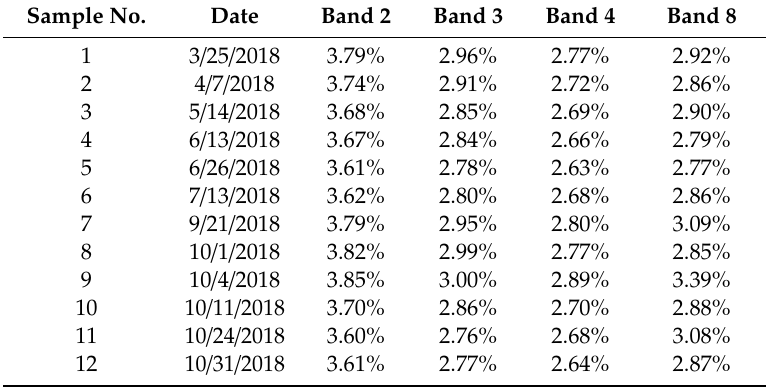
Table 3. The combined uncertainty results of the retrieved surface reflectance in bands 2, 3, 4, and 8 of Sentinel-2B / MSI.